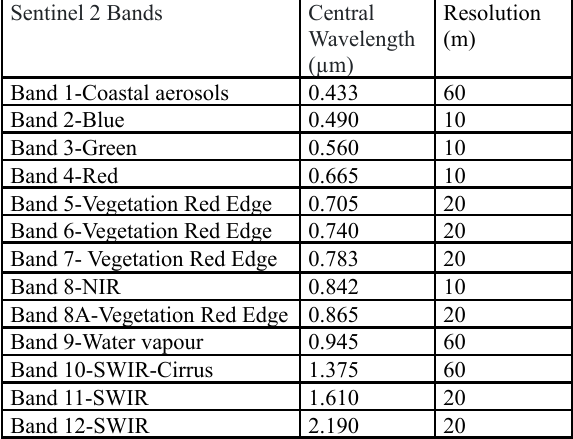
Table 1: Sentinel 2A Bands with central wavelengths and resolution Study Site